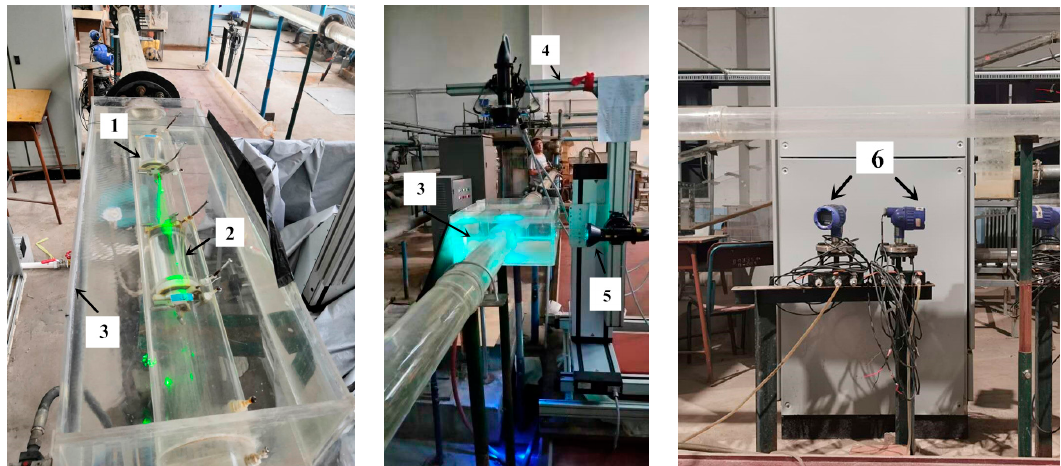
Figure 6. Experimental equipment and instruments. Note: 1. Rear pipe vehicle. 2. Front pipe vehicle.